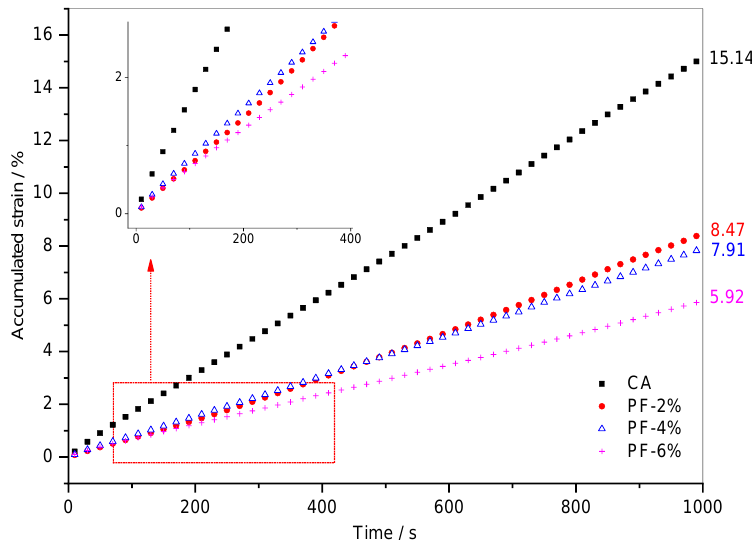
Figure 6. Evolution of accumulated strain versus time for composites with polyester fiber.